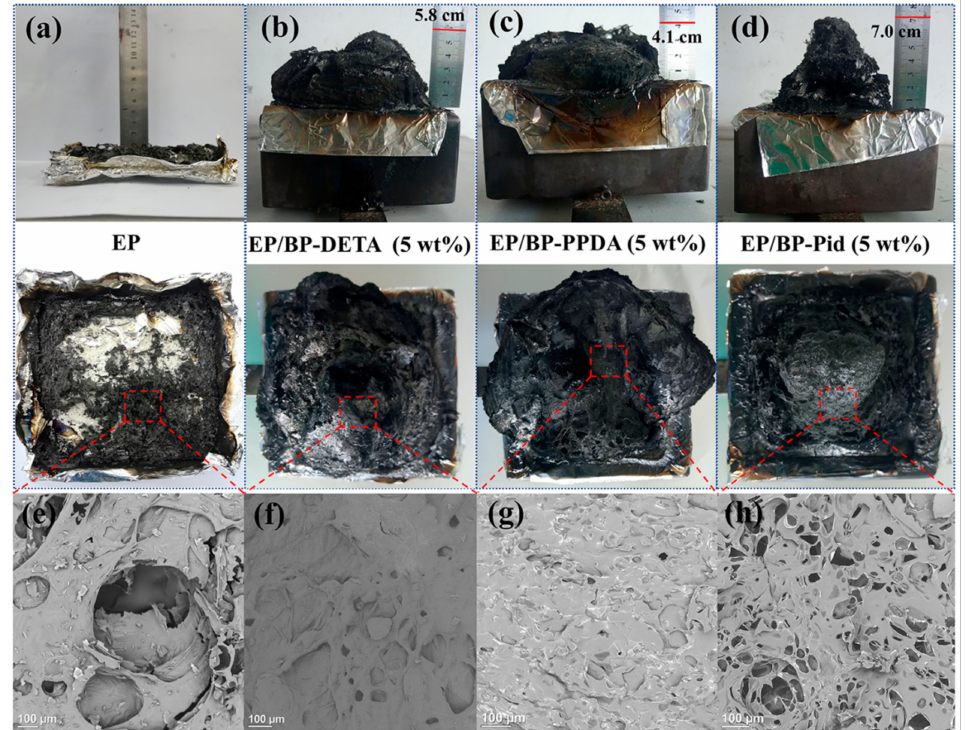
Figure 8. Digital photos of the external residues ( a – d ) from a top view and a side view for pure EP and EP/BP-NH 2 nanocomposites; SEM images of interior ( e – h ) char residues for pure EP and EP/BP-NH 2 nanocomposites.